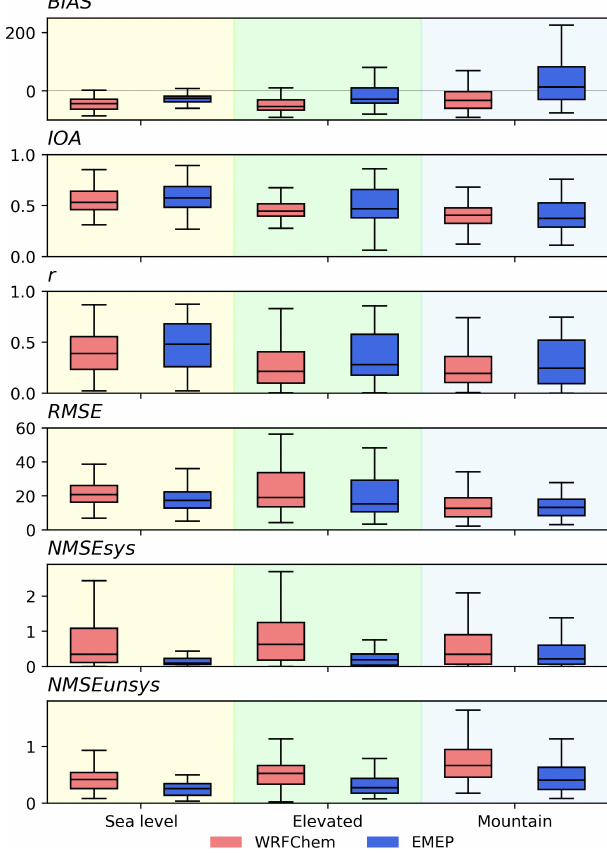
Figure 8. Intercomparison of the applied statistical mea- sures (BIAS, IOA, r , RMSE, NMSEsys, NMSEunsys) be- tween measured ( PM 10 ) d (310 rural background stations from AirBase, https://www.eea.europa.eu/data-and-maps/data/ airbase-the-european-air-quality-database-7, and the EU-PHARE project) and modelled ( PM 10 ) d with the WRF-Chem (red boxes) and EMEP (blue boxes) models during November 2011 with respect to the station